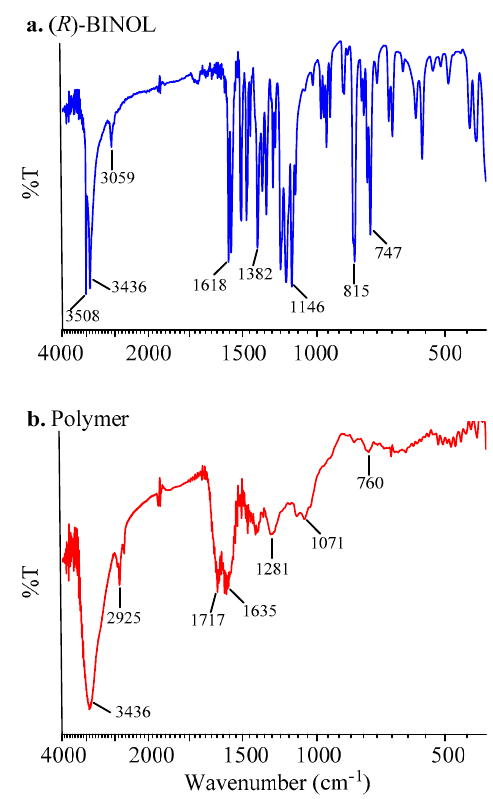
Figure 5. IR spectra: ( a ) ( R )-BINOL; ( b ) the polymeric product obtained from ( R )-BINOL in a CH 3 CN solution upon irradiation for 5 h ([( R )-BINOL] o = 1.0 × 10 − 3 M, cell path = 5 mm) [KBr pellet].